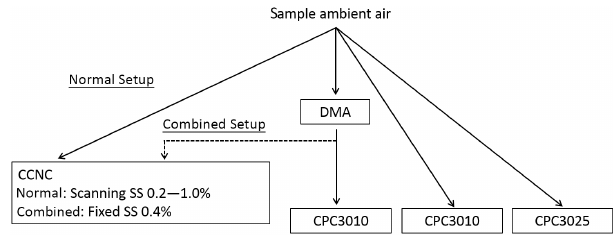
Figure 1. Scheme of the two different measurement modes for the cloud condensation nuclei counter (CCNC). When CCN size- resolved number concentration measurements took place, the CCNC was connected behind the Differential Mobility Analyzer and the supersaturation was set to 0.4%. During normal operation, the CCNC was connected parallel to the DMA and SS alternated between 0.2 and